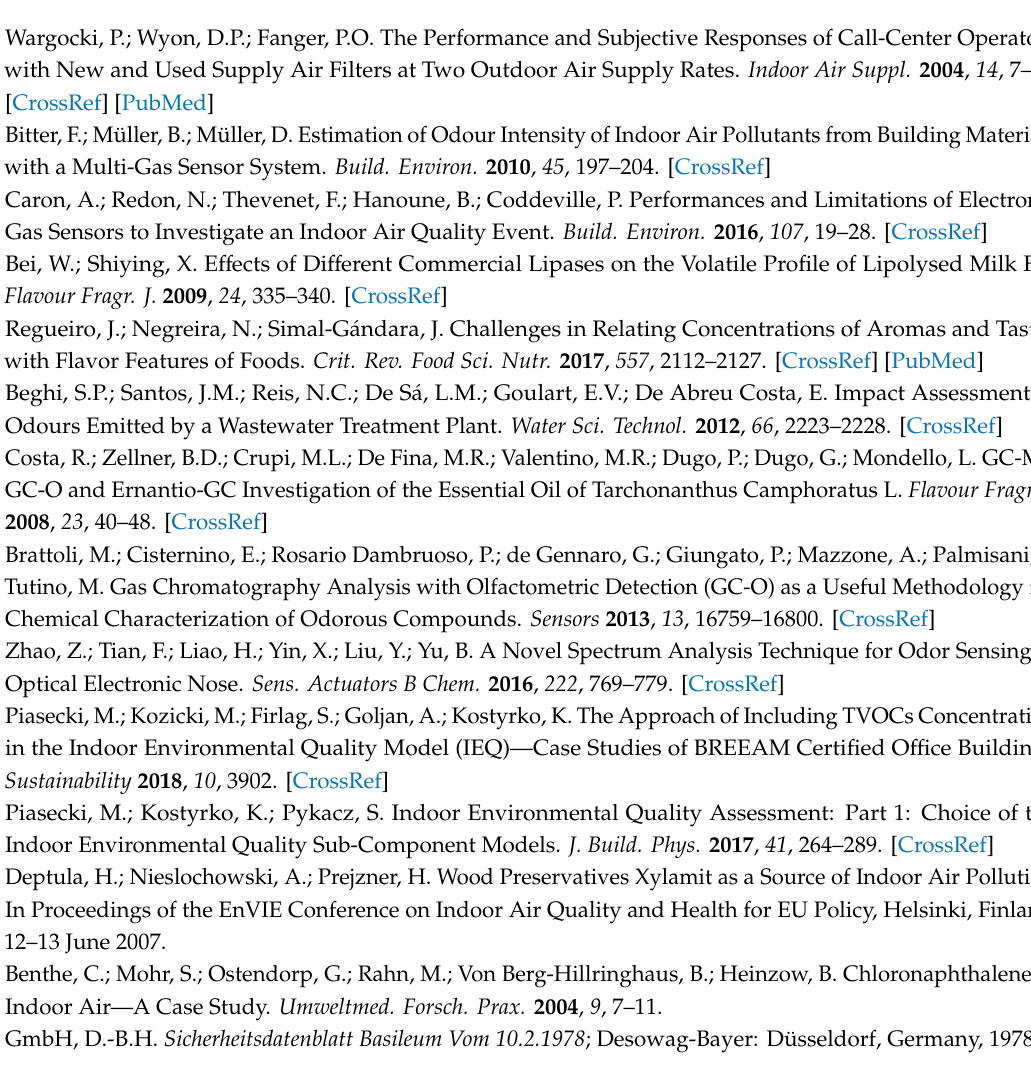
Table S1: Table VOC emission from samples of construction products taken from di ff erent buildings. In total, 73 samples were taken from 32